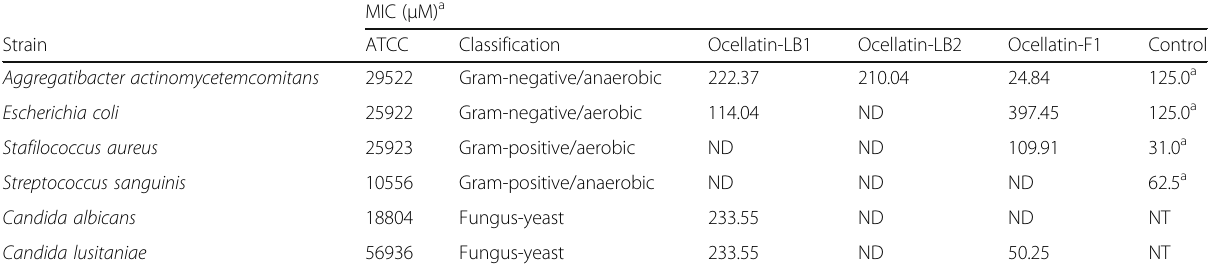
Table 3 Minimal inhibitory concentrations determined for ocellatin-LB1, -LB2 and -F1 in the presence of bacteria and fungi